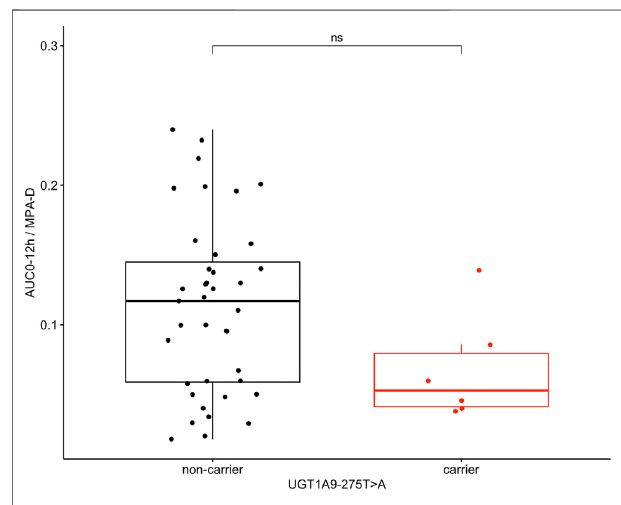
FIGURE 4 | Area under the curve in 12 h normalized by MPA dose requirements